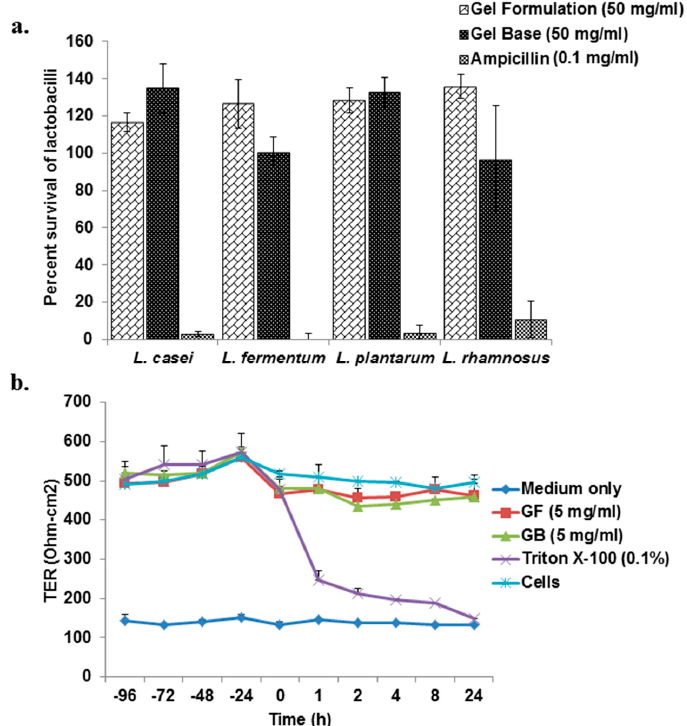
Figure 5. Effect of gel formulation on the survival of lactobacilli and integrity of the epithelial monolayer. ( Panel a ) Four lactobacilli strains (10 8 CFU/mL) were cultured in presence or absence of gel formulation/gel base (50 mg/mL). Ampicillin (0.1 mg/mL) was used as positive reference control.